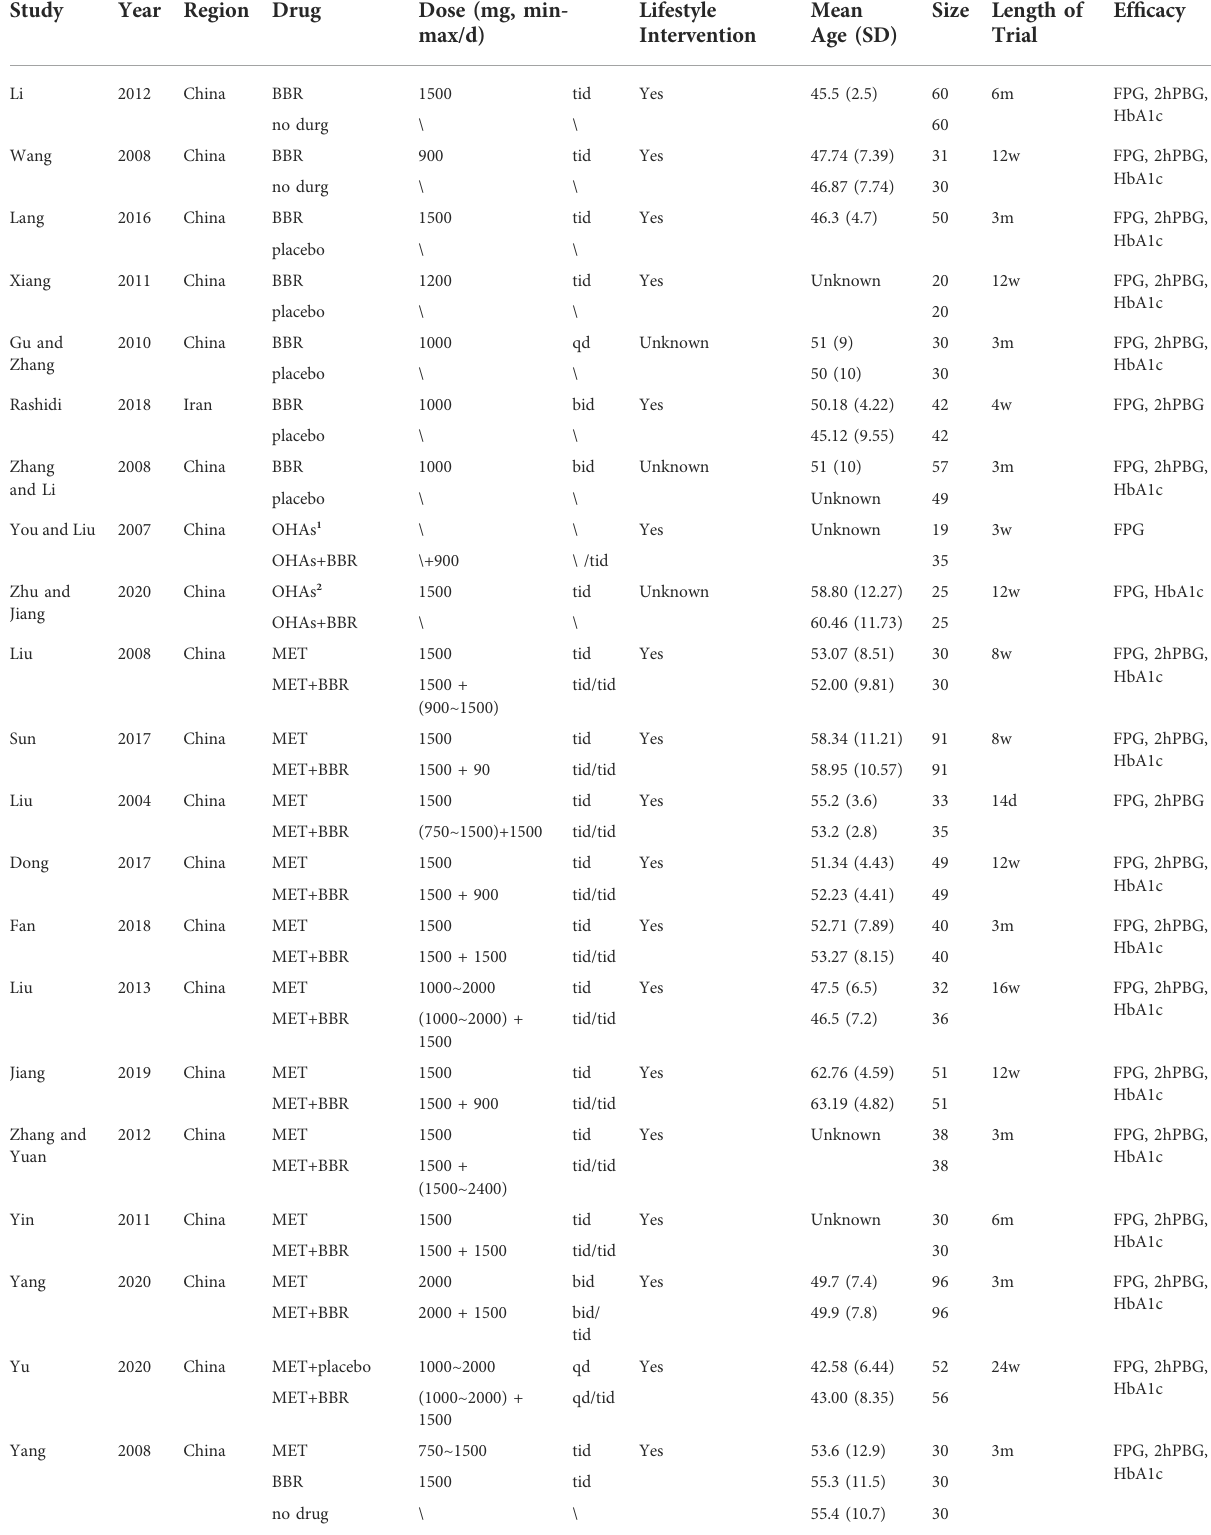
TABLE 2 Characteristics of included studies in the